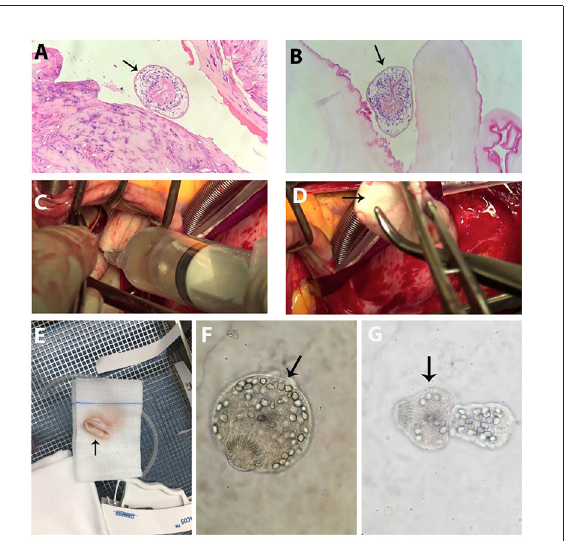
FIGURE3 Surgical findings and Echinococcus larvae. (A,B) Echinococcus larvae (arrow) in the hepatic cyst specimen. (C) Cardiac cyst fluid that looked clear yellow was aspirated. (D) Opalescent white and smooth sphere cyst (arrow) was totally removed from the heart. (E) Cyst specimen (arrow). (F,G) Echinococcus larvae at different stages (arrow) in the cardiac cyst